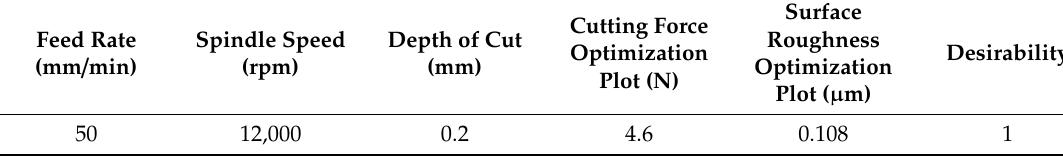
Table 10. Result of the response